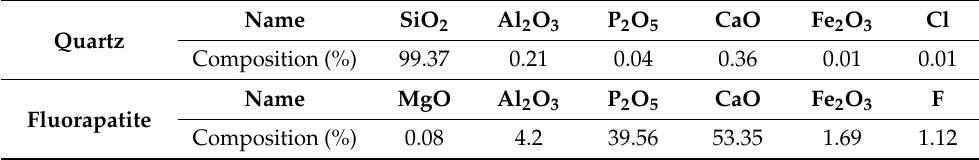
Table 1. Multi-element chemical analysis results of pure minerals. Quartz